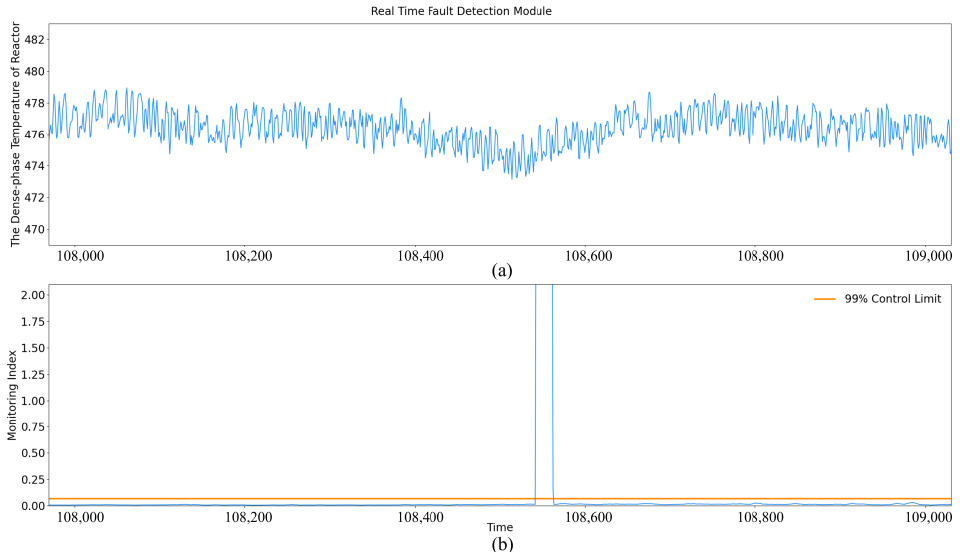
Figure 17. Process monitoring result when the operating mode is adjusted: (a) Original data of the key variable; (b) Fault detection results.